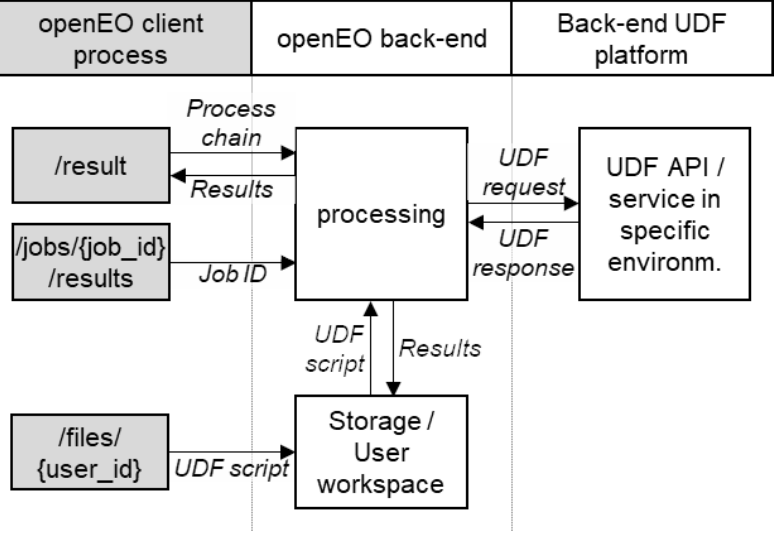
Figure 2. Processing of user-defined functions